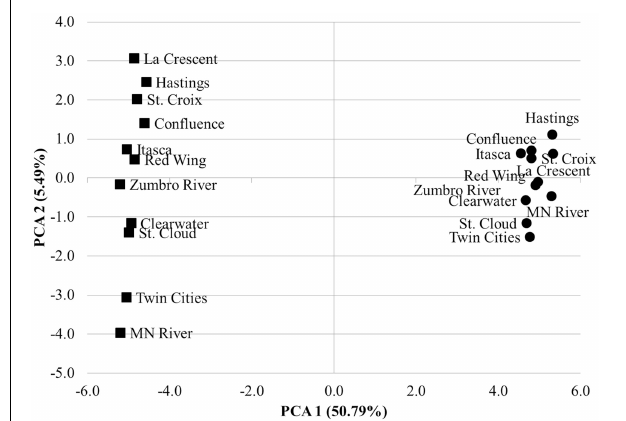
FIGURE 4 | Principal component analysis comparing 2nd tier KO functional traits derived from shotgun metagenomic analysis (circles) and PICRUSt-inference (squares). Traits were normalized as percentages of total genes assigned for both